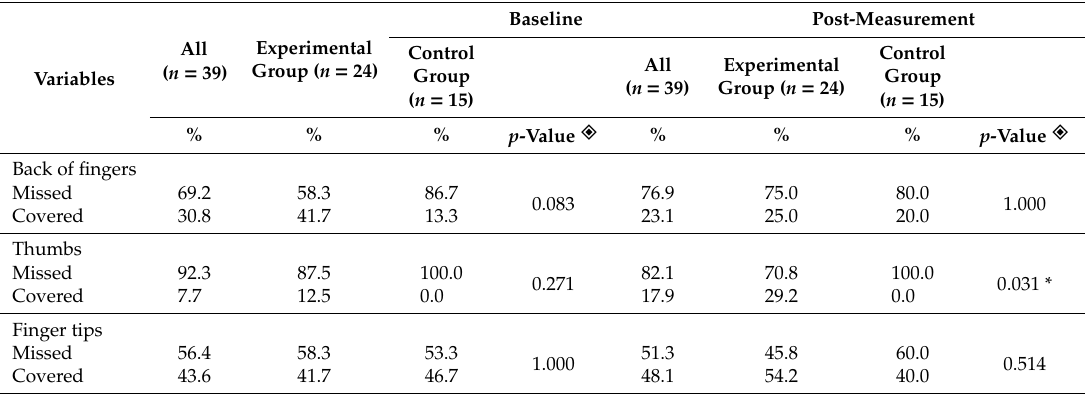
Table 4. Hand coverage using alcohol-based hand rub by gender. Table 2. Within-group and between-group comparisons of hand coverage (%) using hand sanitizer.